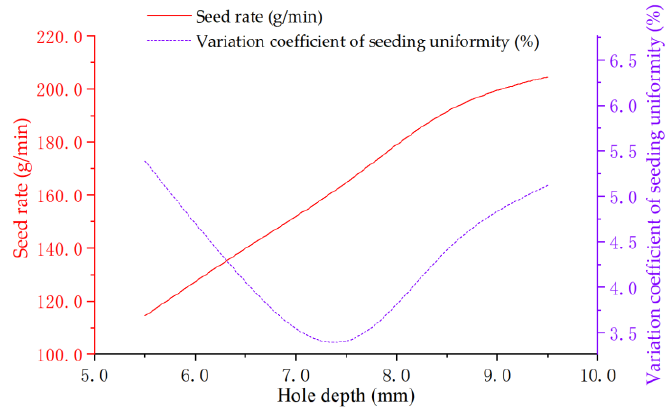
Figure 12. Relationship curve between hole depth and each index.